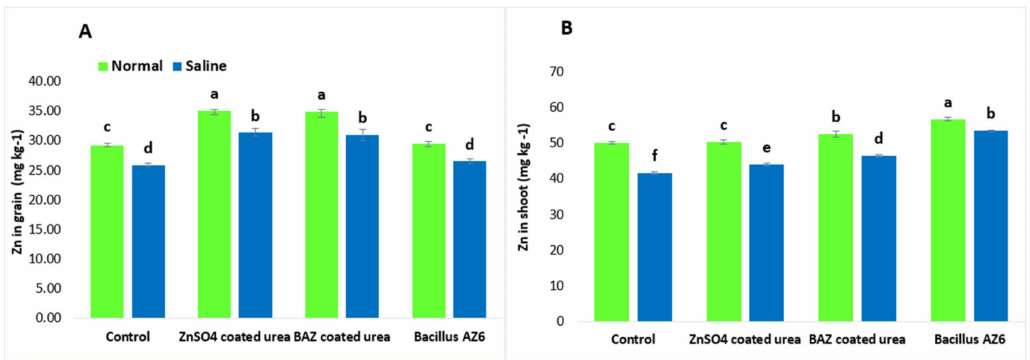
Figure 2. The Zn concentration in the shoots ( A ) and grains ( B ) of wheat grown with BAZ-coated urea under salinity stress. The presented data are the means of three replications ( n = 3) ± standard error. The same alphabetical letters above error bars show that di ff erent treatments were not significantly di ff erent ( p ≥ 0.05) from each